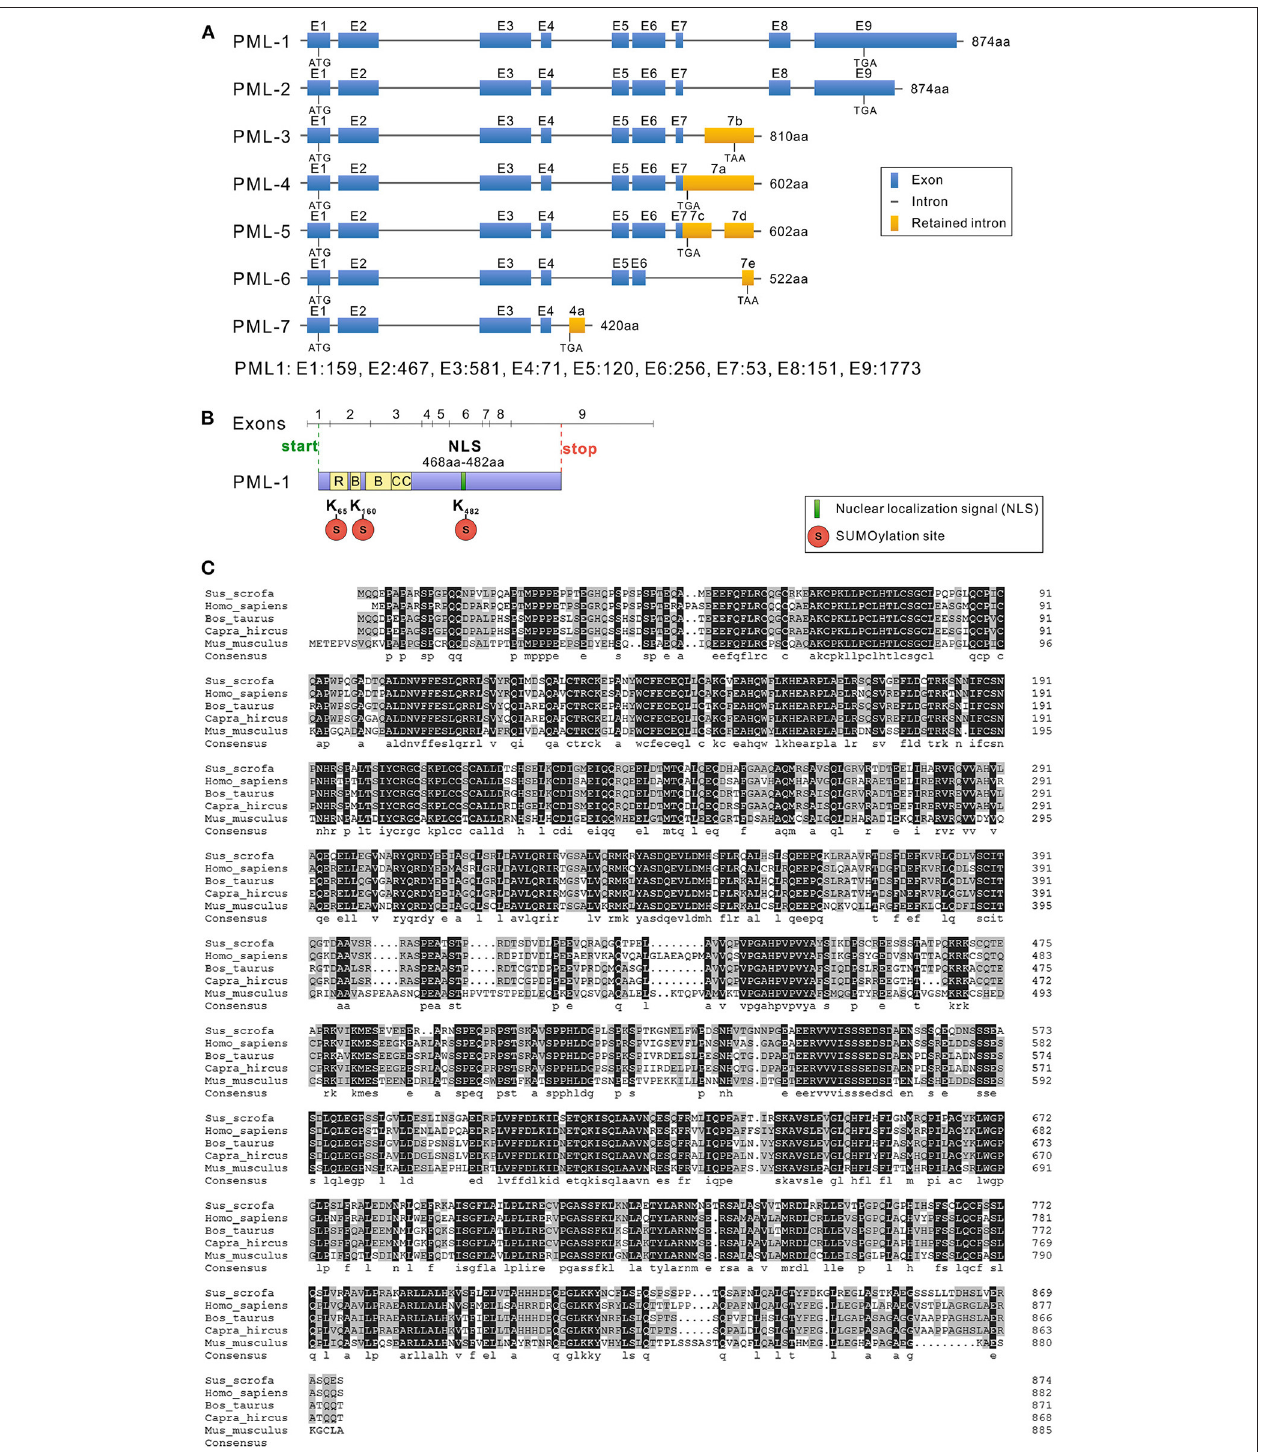
FIGURE 2 | Structure and sequence analysis of porcine PML isoforms. (A) The lengths of seven PML isoforms (PML-1 to PML-7) encoded by the different mRNA variants and their exon compositions from the translational start codons to the stop codons of the mRNA are shown. The full-length genomic sequence of PML includes nine exons (1–9). Alternative splicing of the PML gene leads to seven mRNA variants. Exon length: exon 1, 159 bp; exon 2, 467 bp; exon 3, 581 bp; exon 4, 71 bp; exon 5, 120 bp; exon 6, 256 bp; exon 7, 53 bp; exon 8, 151 bp; exon 9, 1,773 bp. (B) Conserved domain analysis of PML-1. (C) Sus scrofa , Homo sapiens , Bos taurus , Capra hircus , and Mus musculus PML-1 amino acid sequence alignment was performed with DNAMAN 5.0 software. Identical amino acids are indicated by a black background, and amino acids with substitutions are shown in light gray.